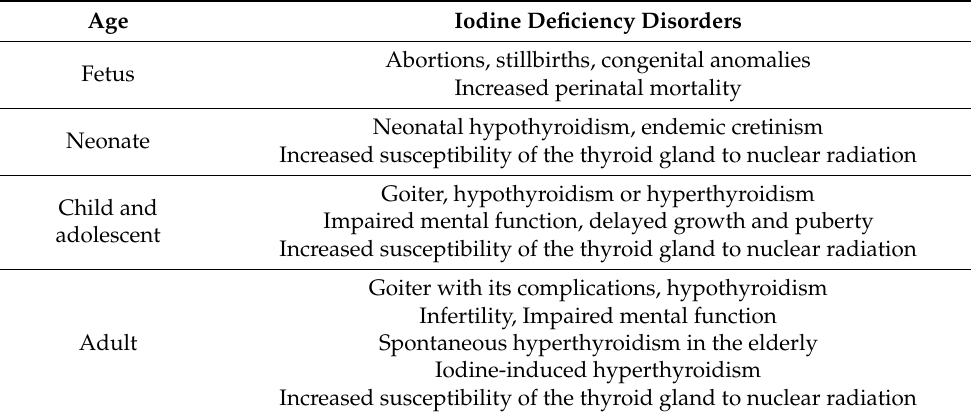
Table 4. Iodine deficiency disorders at different ages. Adapted from